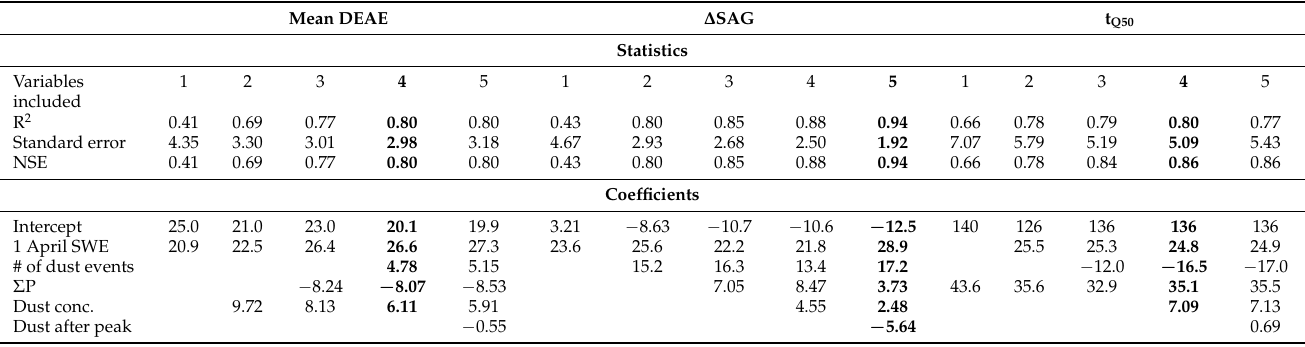
Table 2. Progression of multi-variate linear regression as the R 2 values increased between mean daily DEAE (left side of table), ∆ SAG (middle), t Q50 (right side) and the independent variables from Table 1, plus the fraction of dust events that occurred after peak SWE (Figure 3d). The standard error (with units of W/m 2 for DEAE, days for ∆ SAG, t Q50 as day of year) and the Nash–Sutcliffe Efficiency (NSE) coefficient are included. The optimal models are presented in bold face (four variables for DEAE, five for ∆ SAG, and four for t Q50 ). The coefficients were derived from standardizing the independent variables to a value between 0 and 1. All regressions are significant at p < 0.05. ∆